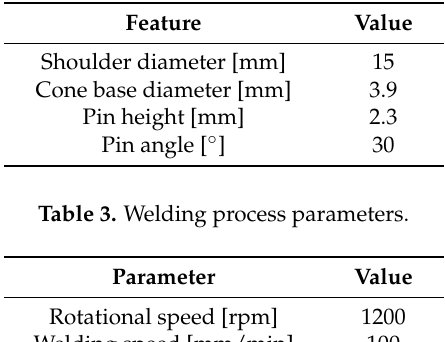
Figure 1. Experimental setup of the Friction Stir Welding (FSW) process. Table 2. Geometric features of the conical pin tool in H13 tool steel used in the FSW experiments.